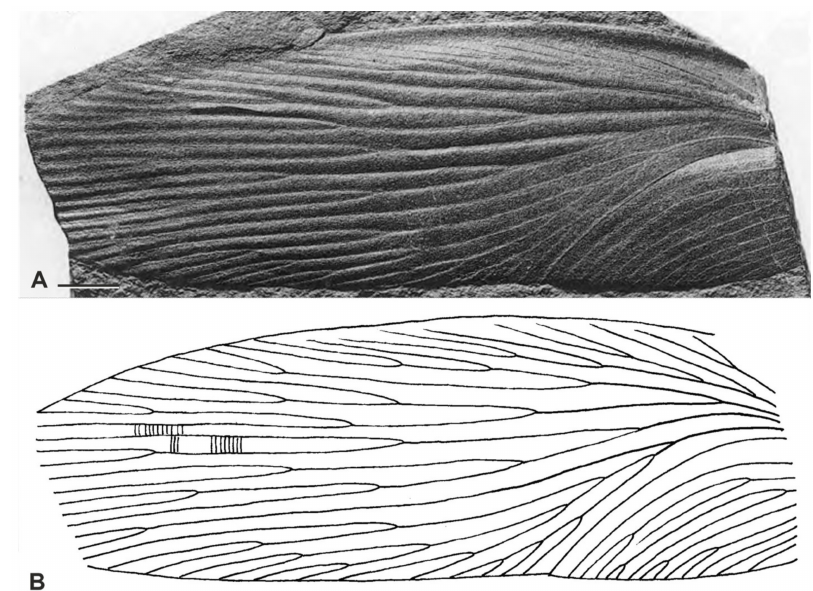
Figure 9. ( A , B )— Progonoblattina clarkii (Scudder, 1893): type specimen of ‘ Cebeniblatta marcellini ’ Laurentiaux, 1950; Moli è res-sur-C è ze; MHNN; reconstructed length 71 mm; scale bar 5 mm; photo: from Laurentiaux,